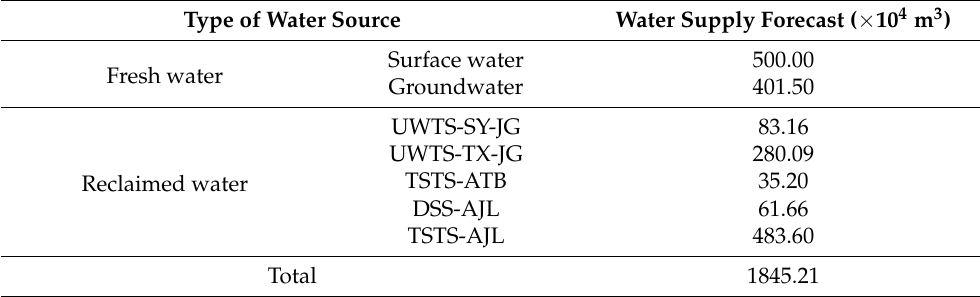
Table 6. Water supply forecast in 2030. The meaning of the abbreviations is shown in Table 1. Type of Water Source